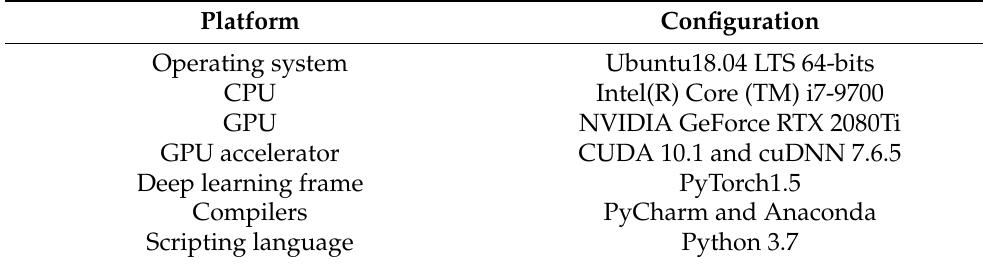
Table 3. Configuration of the experimental environment.